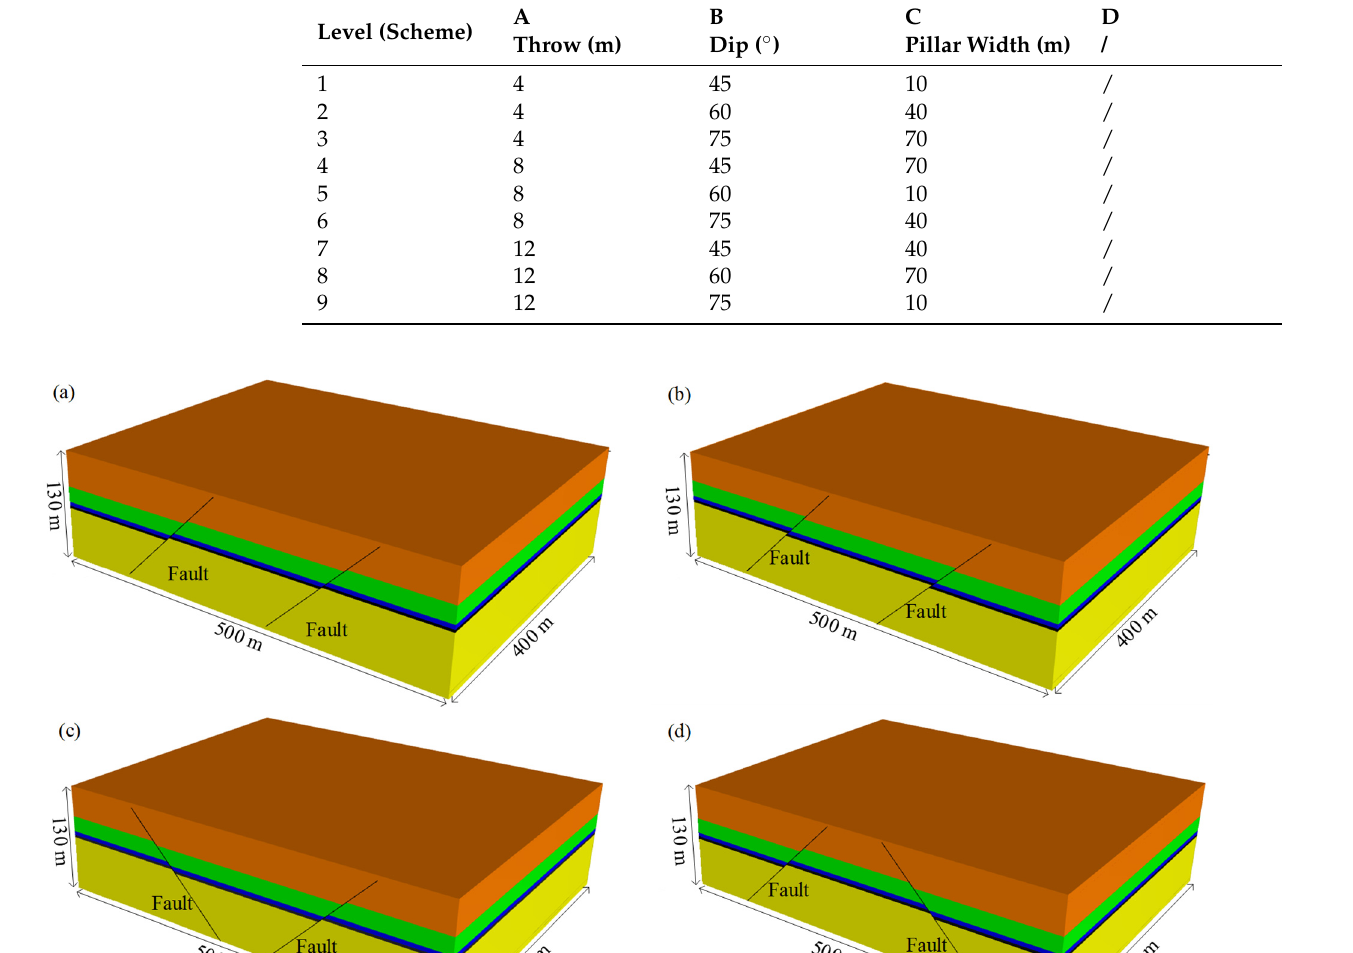
Minerals 2021 , 11 , x FOR PEER REVIEW Minerals 2021 , 11 , x FOR PEER REVIEW 18 of 24 Minerals 2021 , 11 , x FOR PEER REVIEW 18 of 24 Minerals 2021 , 11 , x FOR PEER REVIEW 18 of 24 Minerals 2021 , 11 , x FOR PEER REVIEW 18 of 24